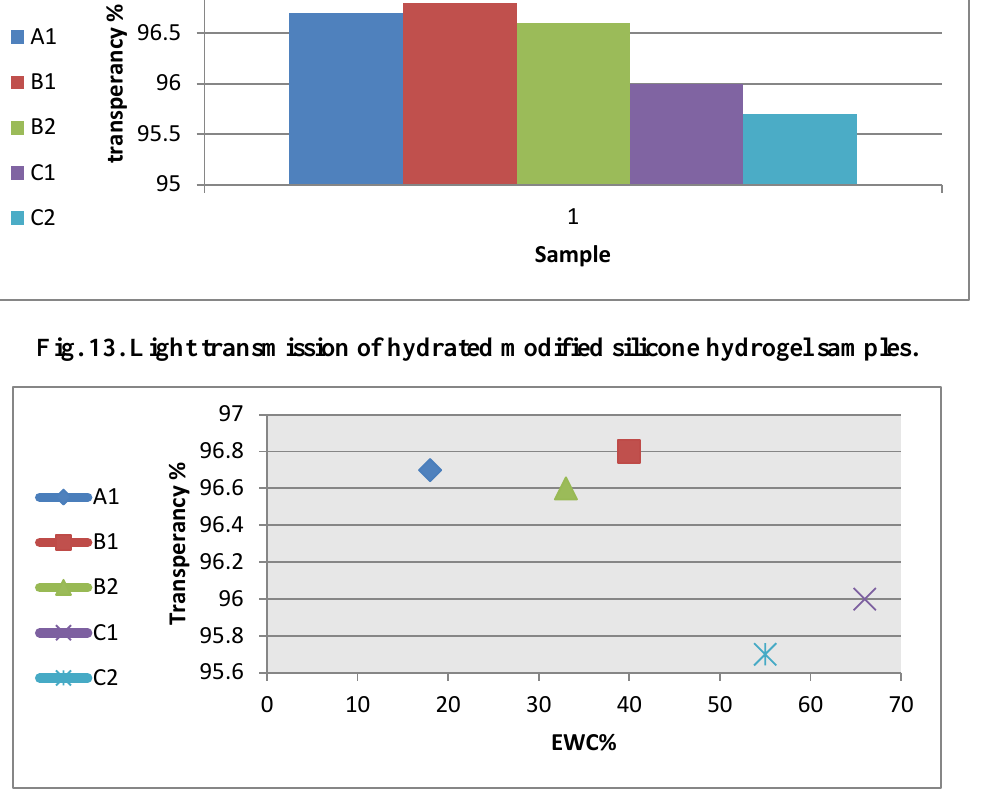
Fig. 14. Worth of transparency by way of a function related to the percentage of EWC in silicone hydrogels.